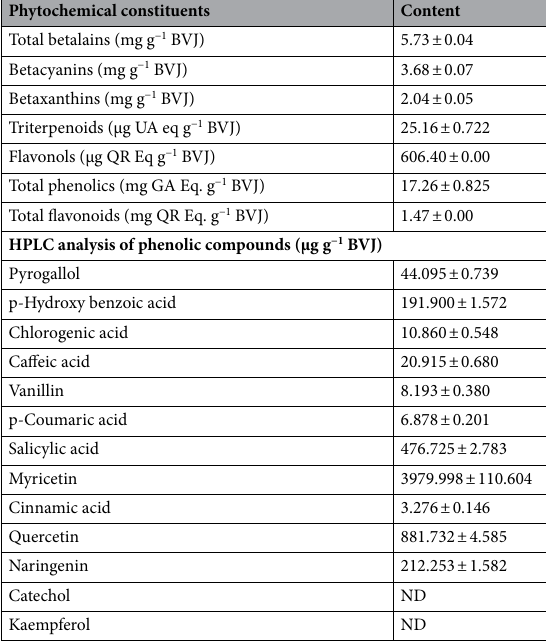
Table 1. Phytochemical content and phenolics HPLC analysis of Beta vulgaris juice (BVJ). The results are presented as mean ± SE (n = 3). QR quercetin, UA ursolic acid, GA gallic acid, Eq equivalent, ND not